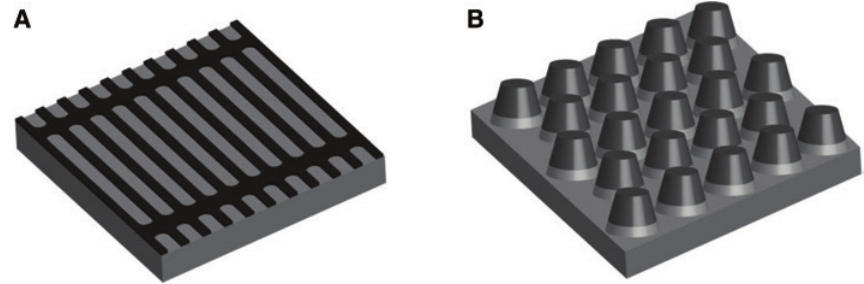
Figure 23: Two non-metal-based substrates for